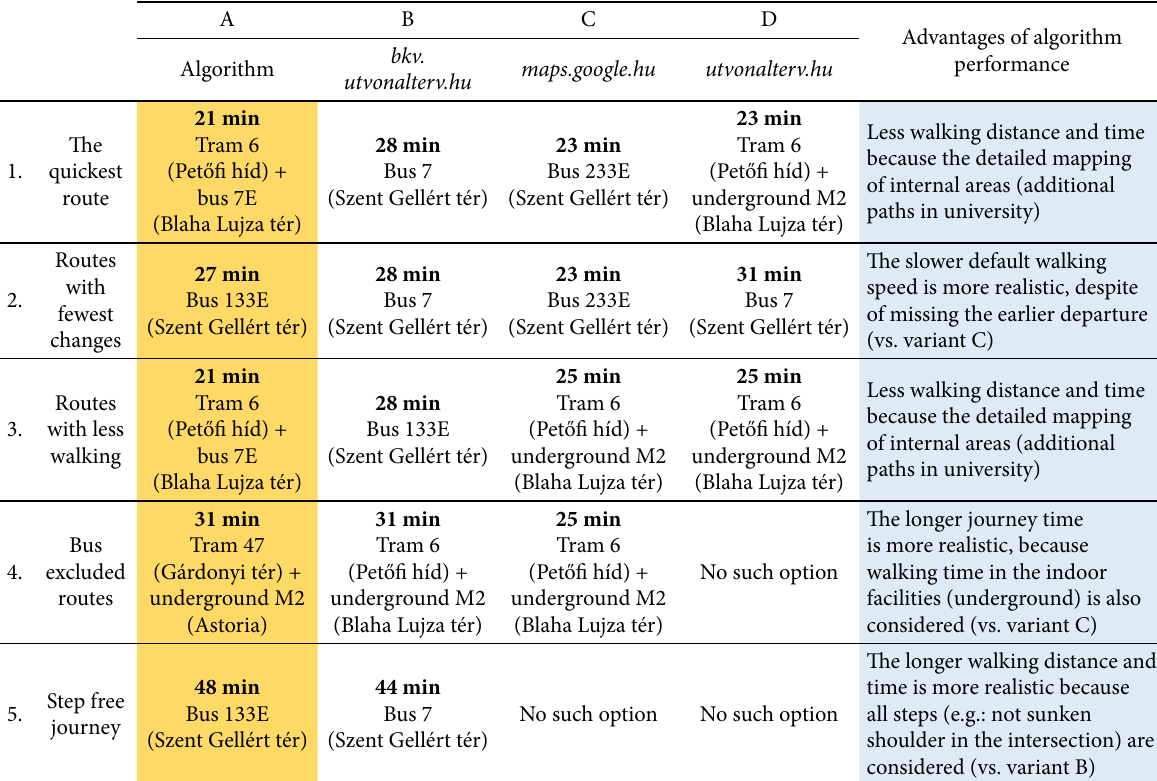
Advantages of algorithm